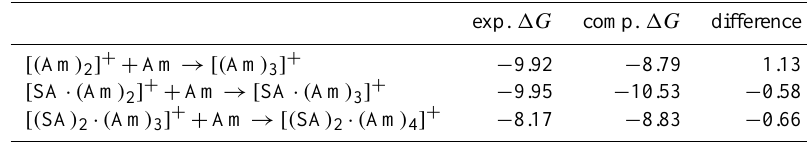
Table 4. Experimental (Froyd and Lovejoy, 2012) and computational (B3LYP/CBSB7//RI-CC2/aug-cc-pV(T+d)Z) 1G values (kcalmol − 1 ) for ammonia addition.